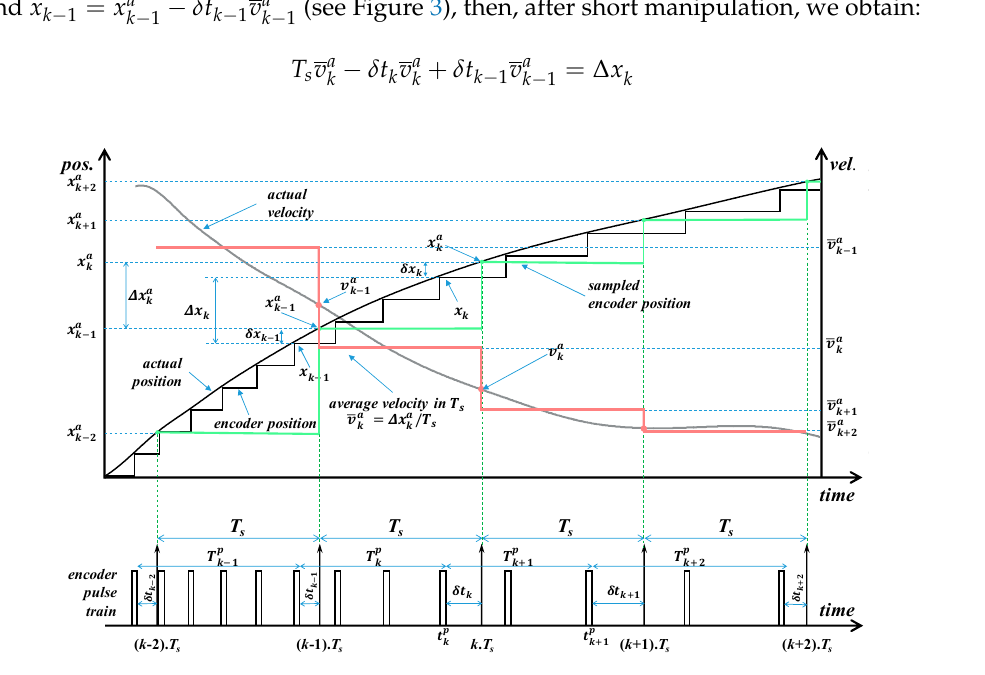
Figure 3. The timing diagram of the division-less MT method [52].